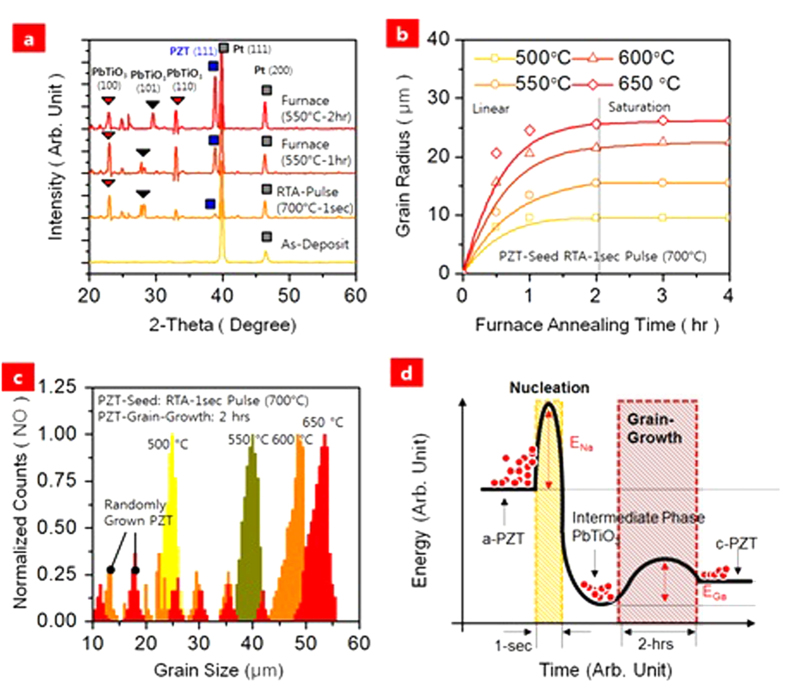
(a) XRD 2-theta profile of as-deposited, after 1-sec pulse of RTA at 700 °C for nucleation, and grain-growth of PZT after 1 and 2 hrs in 550 °C. (b) Grain-growth in SNLC method as a function of furnace annealing time and temperature. (c) Distribution of SNLC-PZT grain size after various annealing temperatures at 2 hrs fixed time. (d) The schematic energy diagram for the SNLC nucleation and growth mechanism.